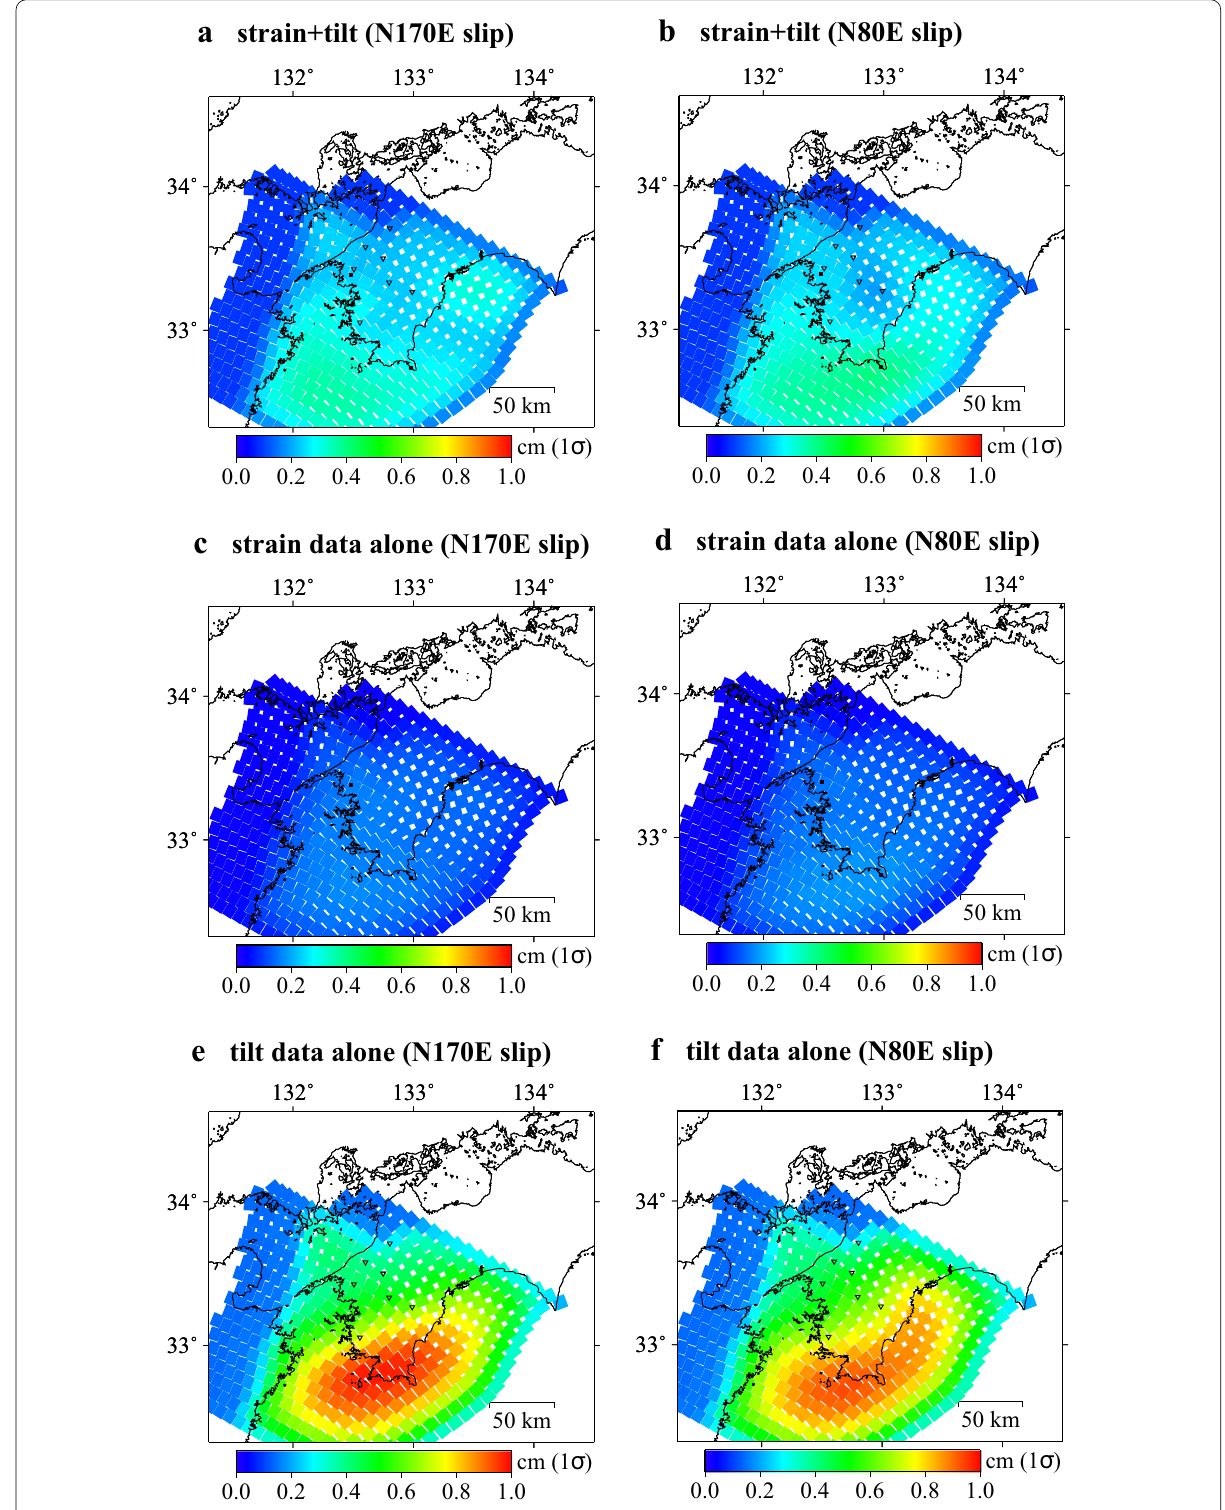
Fig. 18 Distribution of the standard deviation (1 σ ) of the estimated slip (Fig. 17) in the N170E direction (left panel) and N80E direction (right panel) at each subfault. Map region corresponds to Area C in Fig. 1. a , b Standard deviation of the estimated slip based on strain and tilt data. c , d Standard deviation of the estimated slip based on strain data alone. e , f Standard deviation of the estimated slip based on tilt data